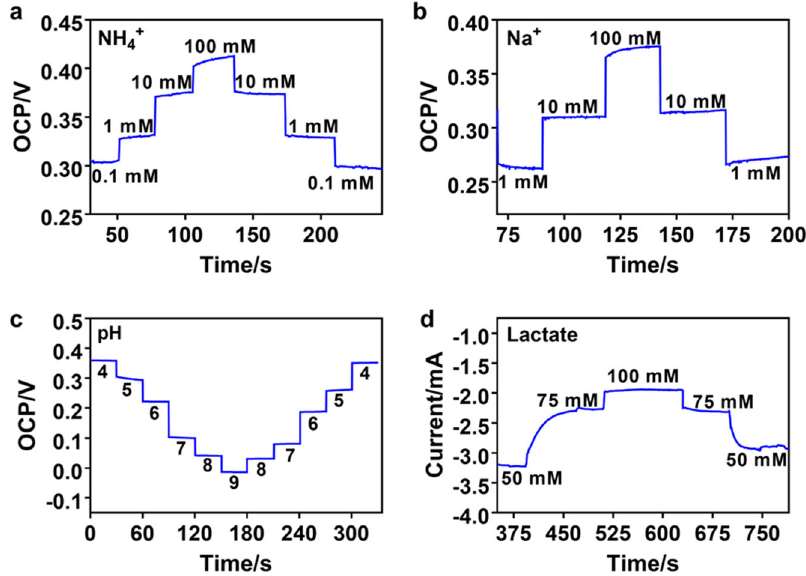
Fig. 5 Step response and hysteresis test of thread-based sweat sensors. Potentiometric response of a ammonium, b sodium, c pH, and chronoamperometric response of d lactate with changes in the analyte concentration without rinsing